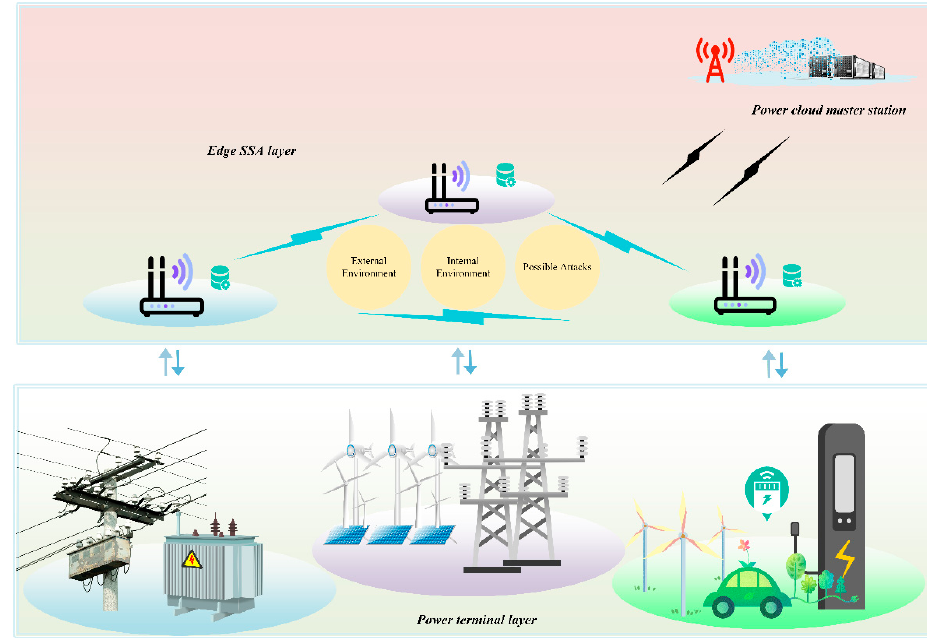
Figure 2. Edge computing paradigm for smart grids security situational awareness.